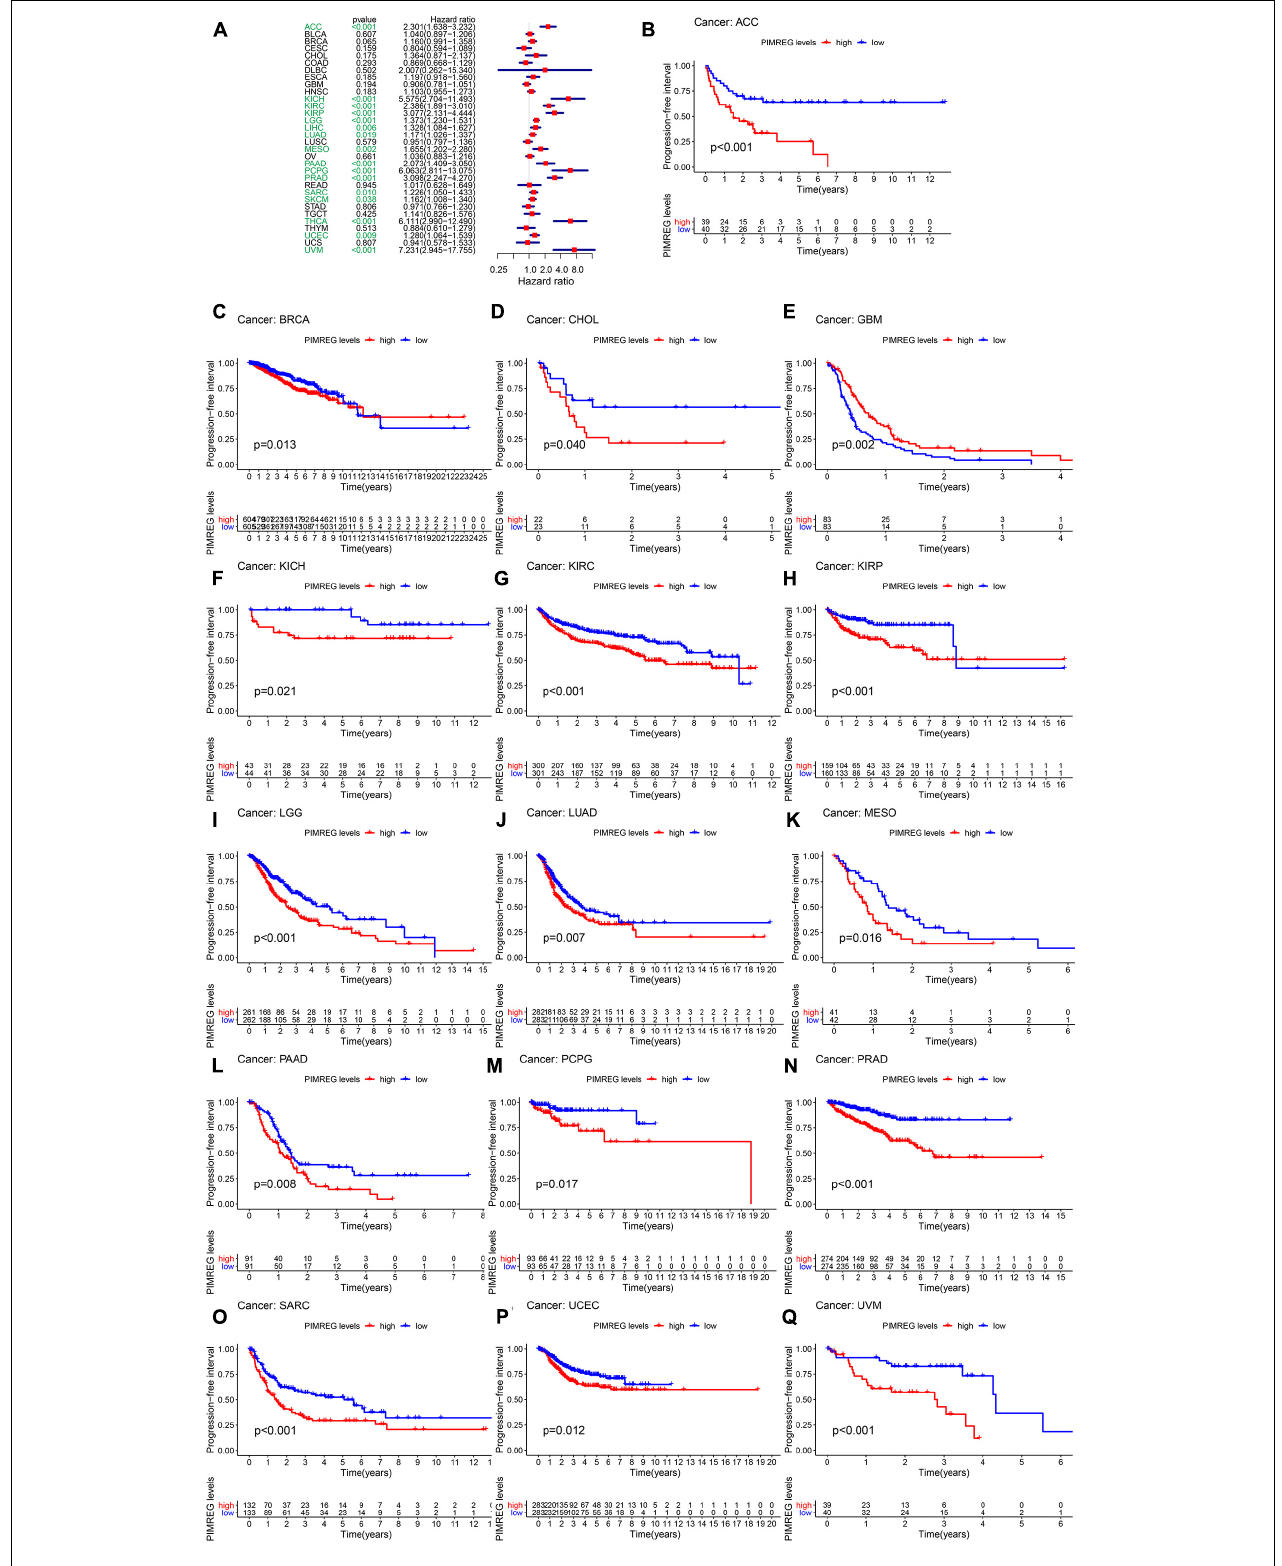
FIGURE 6 | Correlation between the expression of PIMREG and progression-free interval (PFI). (A) Forest plots of PIMREG expression levels in 33 tumors in association with PFI. (B–Q) KM analyses of the relationship of PIMREG expression with PFI.